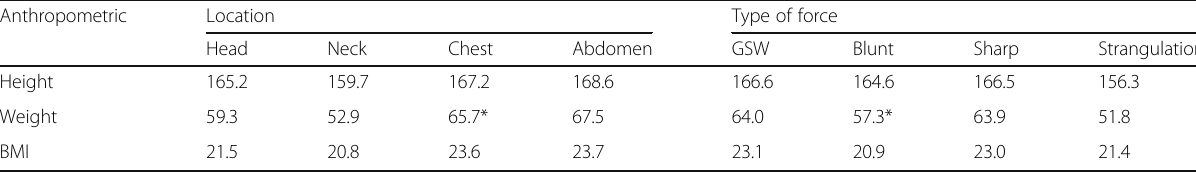
Table 4 The anthropometric data categorized by location and type of